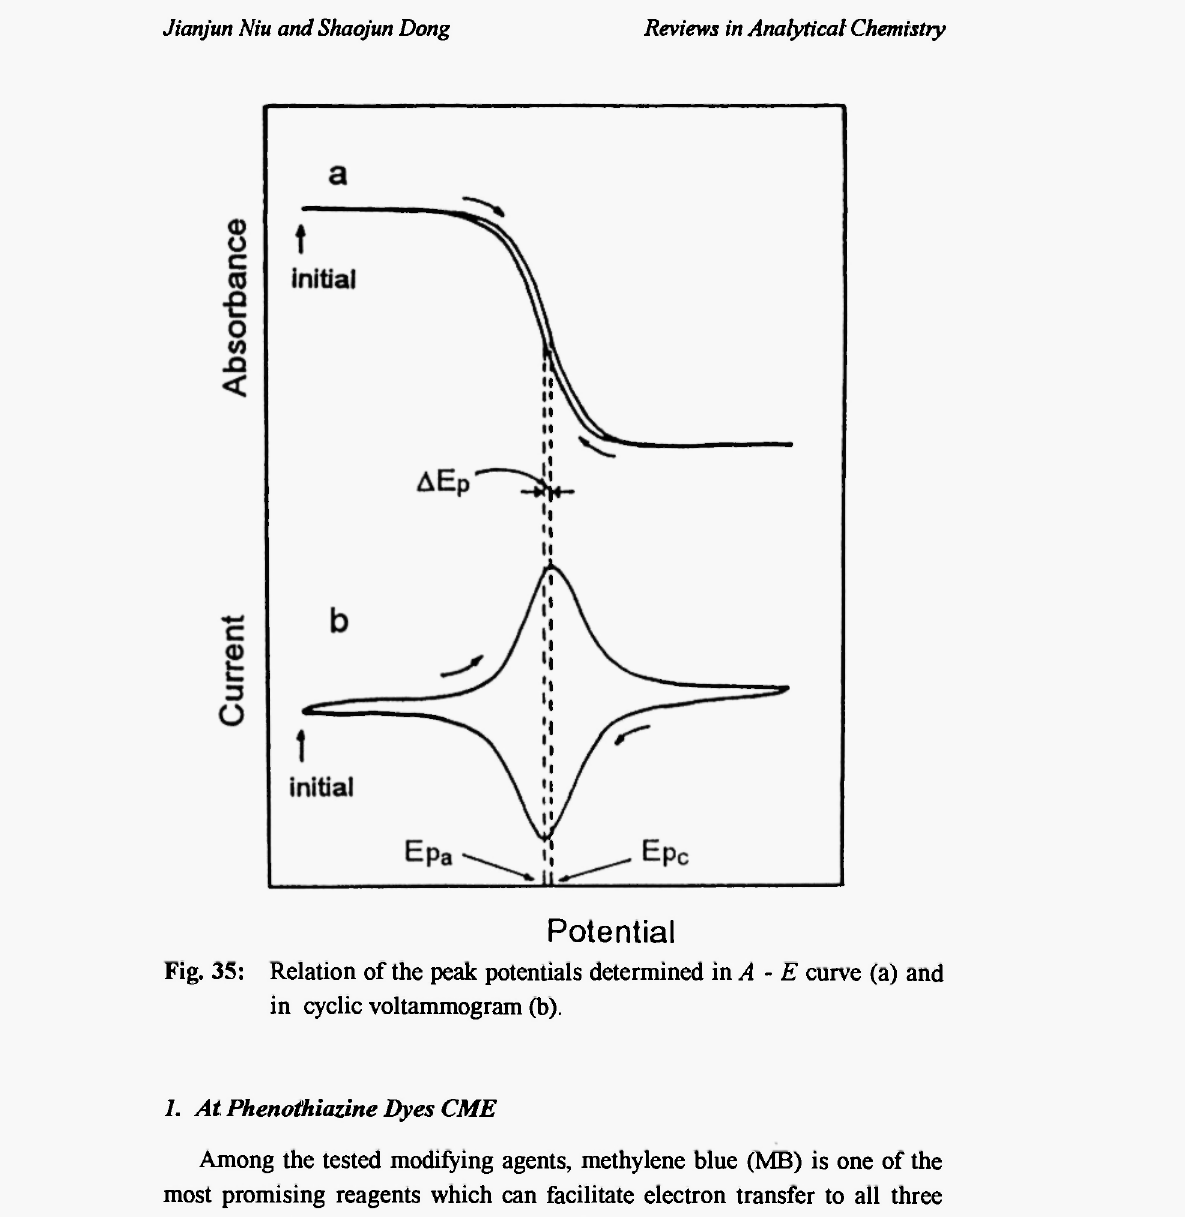
Fig. 35: Relation of the peak potentials determined in A - Ε curve (a) and in cyclic voltammogram